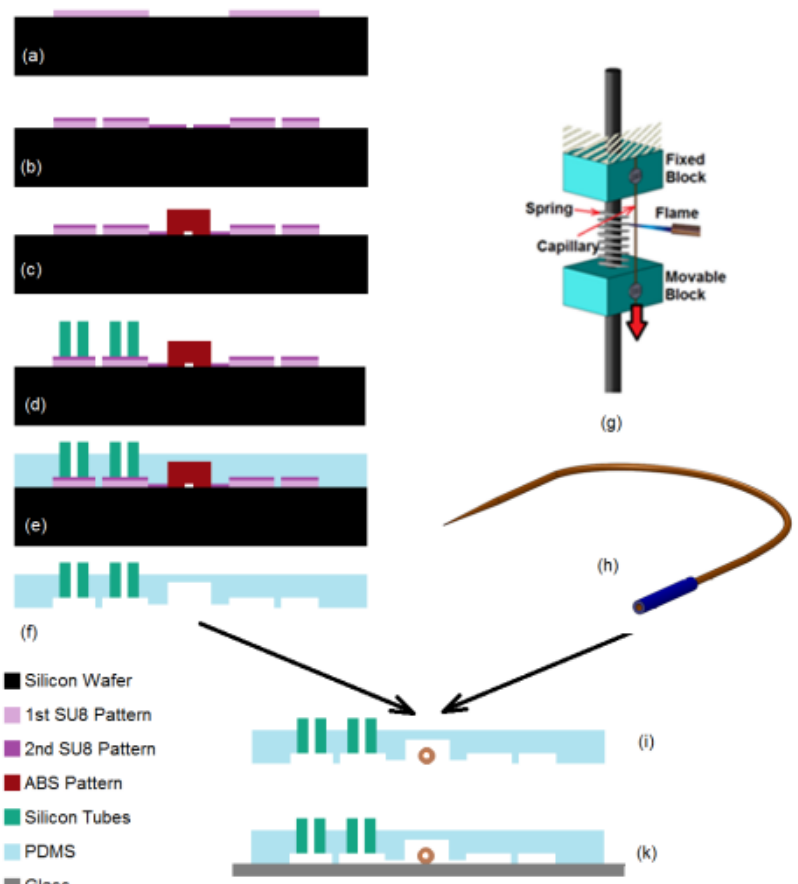
Figure 5. The process flow for device fabrication. ( a ) Pattering of the first SU8 layer with thickness of 40 µm. ( b ) Pattering of the second SU8 layer with thickness of 25 µm on the first layer. ( c ) Attachment of the ABS part (thickness of 2 mm) created by 3D printer to fabricate a hybrid master mold. ( d ) Placement of the interconnectors (silicone tubes) on SU8 pattern. ( e ) Casting of PDMS (1:10) on the mater mold to create a 3 mm device layer and 1mm PDMS membrane for compliant mechanism. ( f ) Peeling off of the PDMS substrate from the master mold. ( g ) Pulling of the microneedle from fused silica capillary and ( h ) Connection of the microneedle to larger capillary to store the reagent. ( i ) Assembly of the microneedle and PDMS chip. ( k ) Bonding of the PDMS chip to the glass slide using dry oxygen bonding.